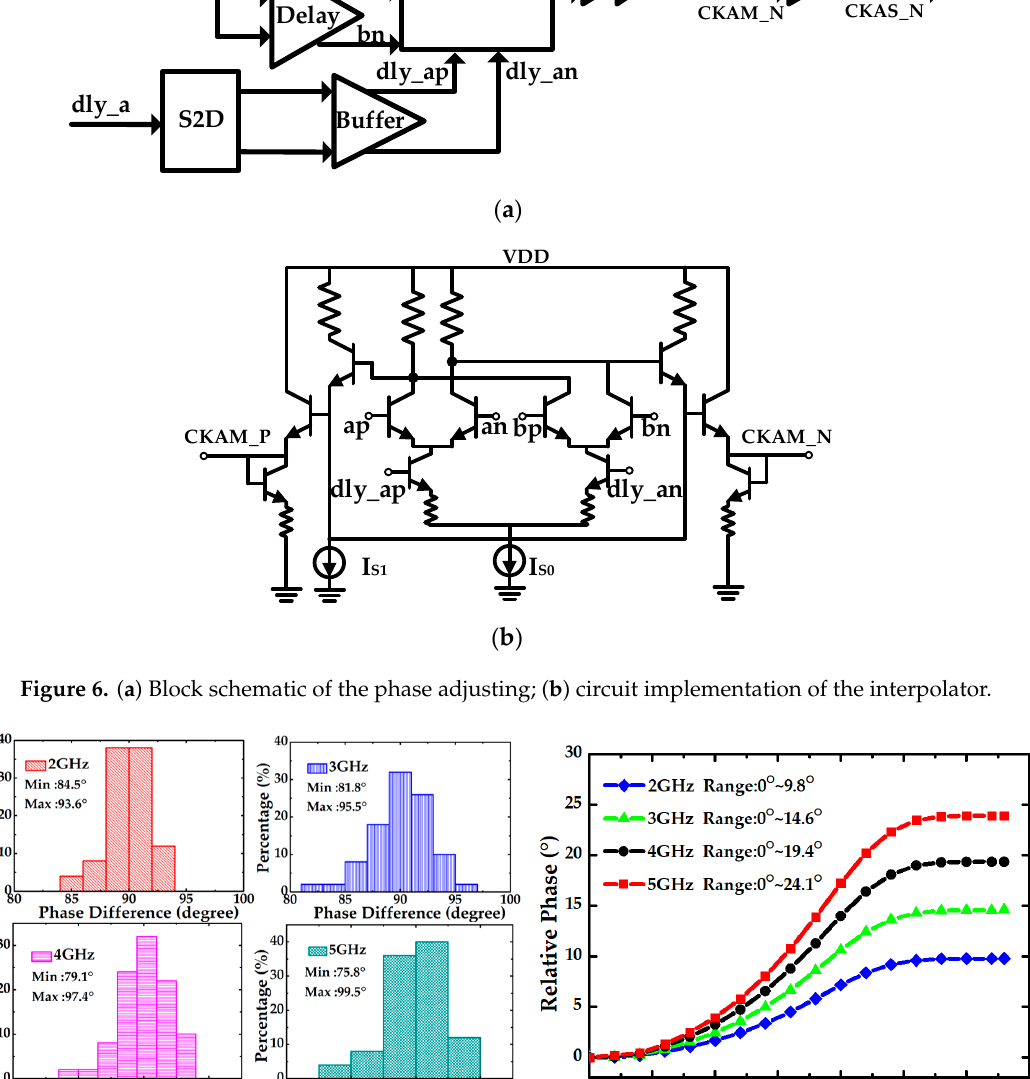
Figure 7. ( a ) Distribution histogram of channel phase difference with different frequency; ( b ) phase- Figure 7. ( a )Distributionhistogramofchannelphasedifferencewithdifferentfrequency; ( b )phase-adjusting adjusting range of the interpolator with different frequency. range of the interpolator with different